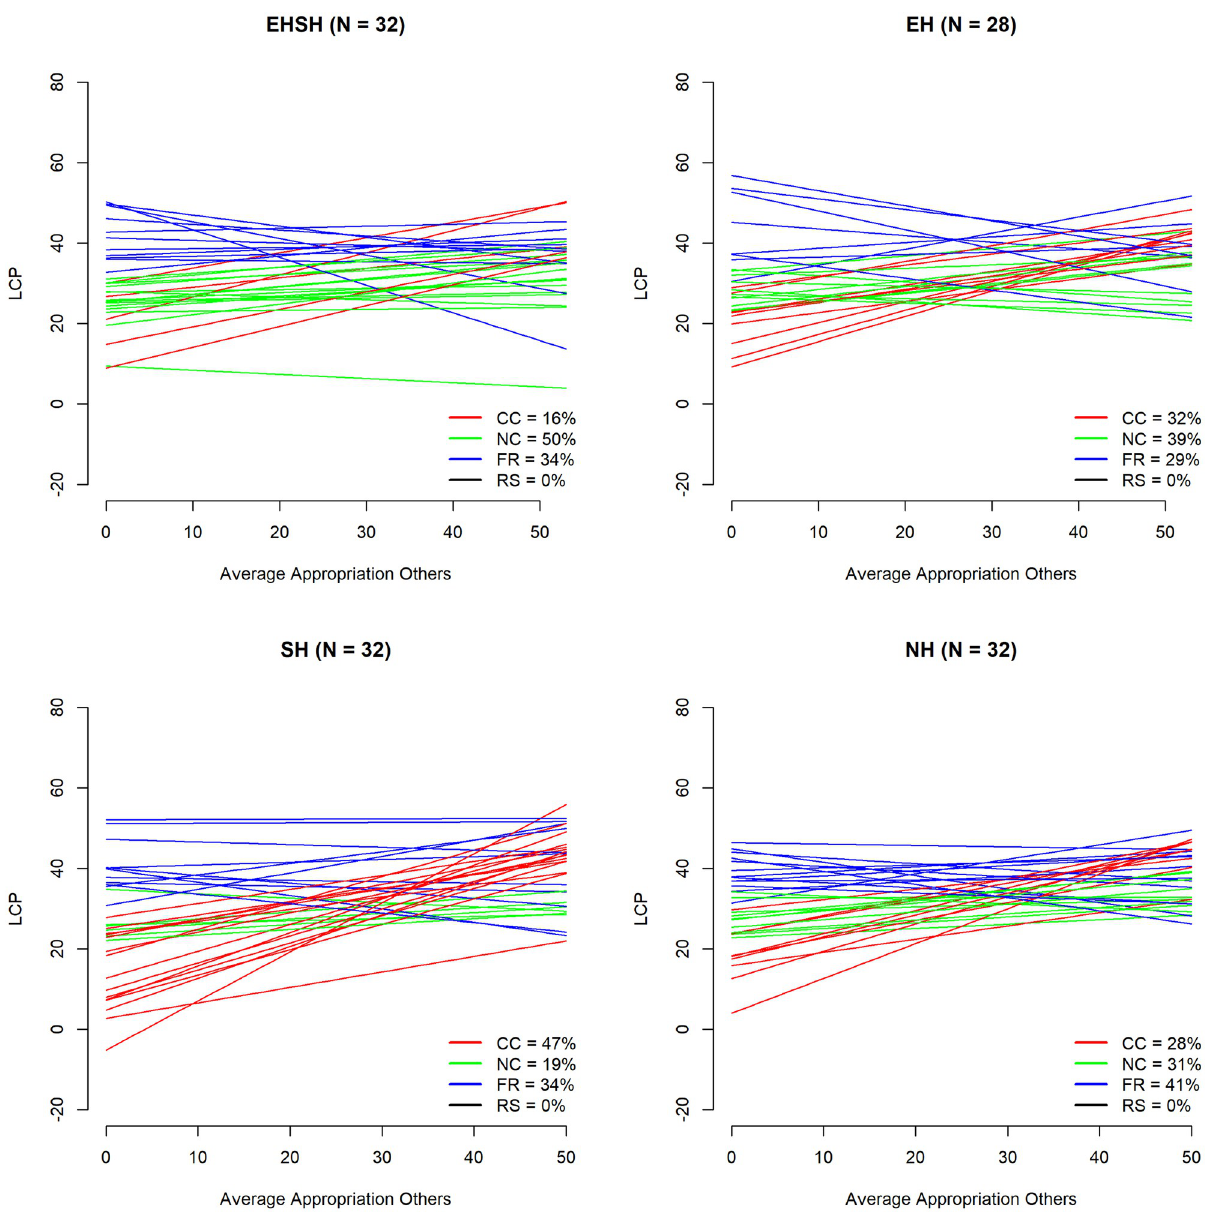
Fig 9. LCP (intercept & slope) by average appropriation of others (t-1) by treatment